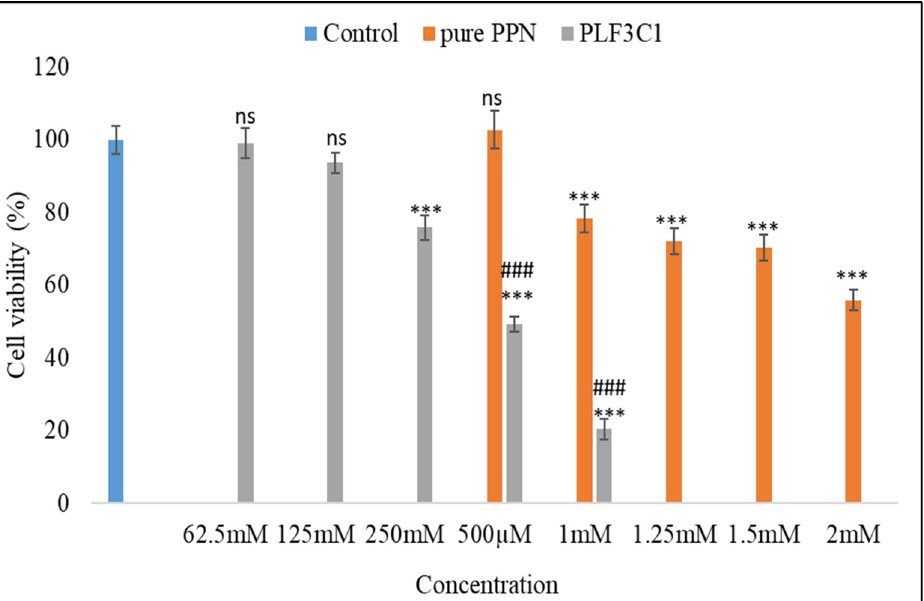
Figure 6. Effect of different concentrations of pure PPN and LF3C1 on the viability of MCF7 cells evaluated by MTT assay. Data are presented in percent (%) in comparison to control as 100%. The Tukey–Kramer multiple comparison test was utilized to analyze the statistically significant difference between different concentration exposures and control. Difference was considered significant if p < 0.05. ns = not significant when compared with control; *** = p < 0.001 when compared with control; ### = p < 0.001 when compared with the same concentration groups of piperine standard.